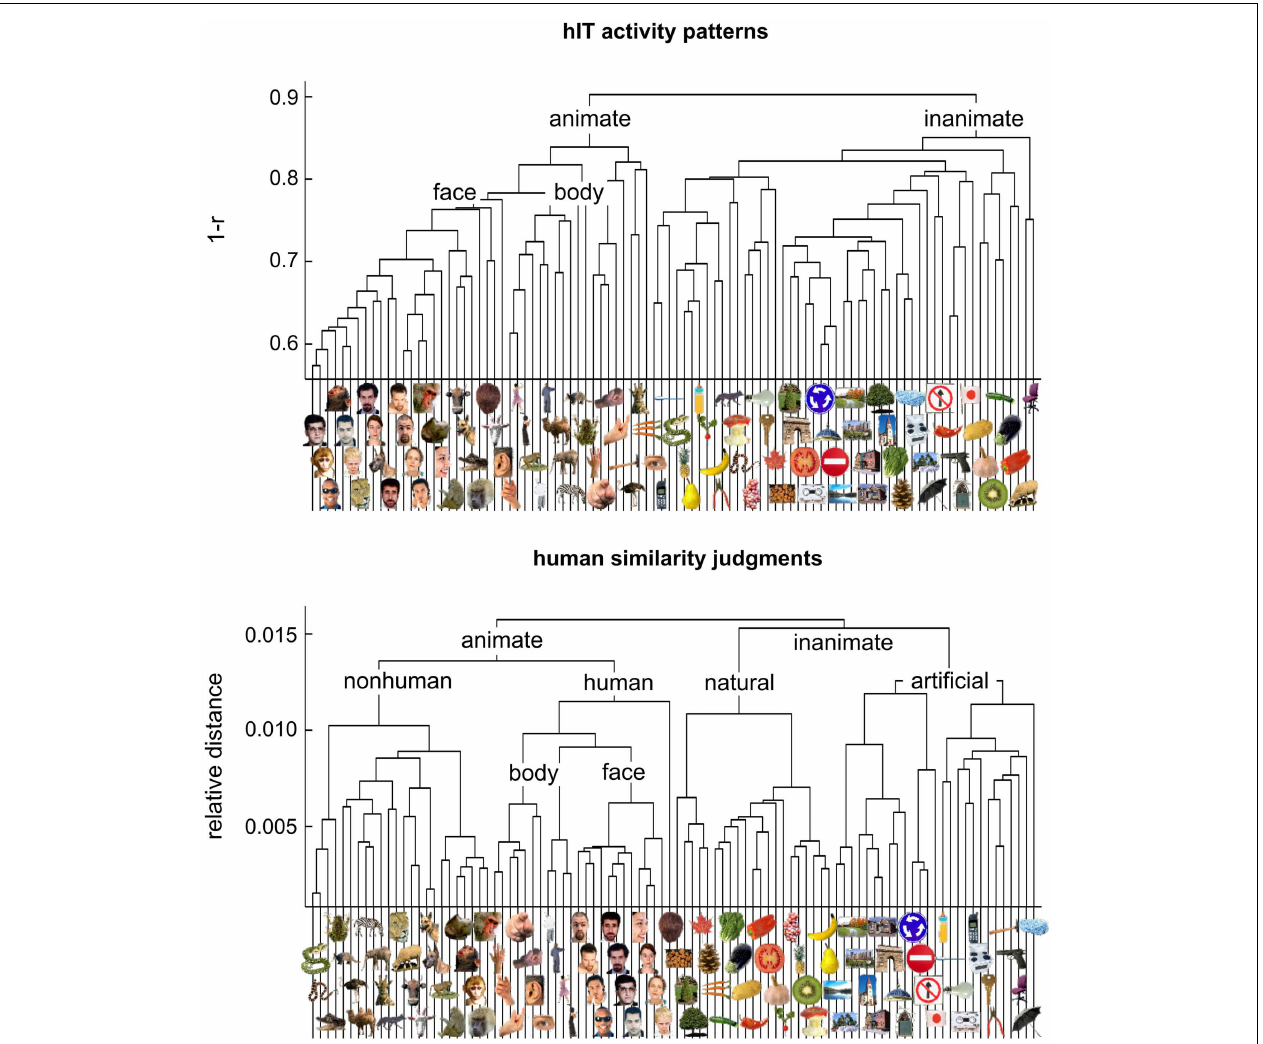
average dissimilarity between the stimuli of two linked subclusters. hIT activity-pattern dissimilarity was measured as 1- r (where r is Pearson correlation coefficient), judged dissimilarity was measured as relative Euclidean distance (using the MA method).Text labels indicate the major clusters. Both hIT activity patterns and human similarity judgments cluster the objects according to natural categories and show a top-level animate/inanimate division. However, the human similarity judgments introduce additional categorical